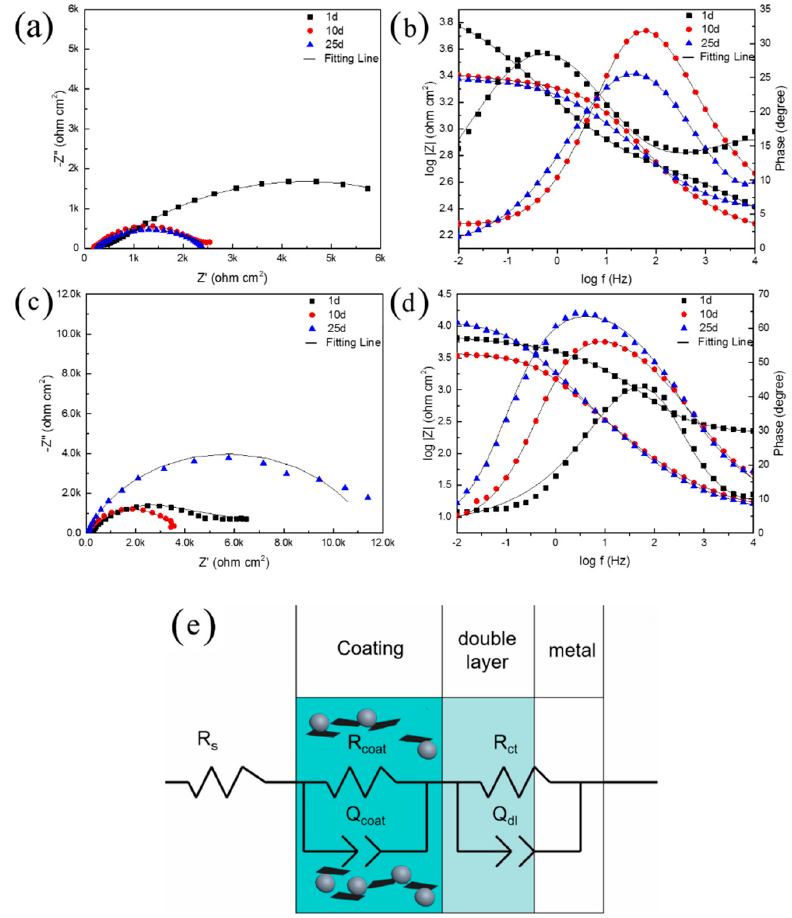
Figure 4. Nyquist and Bode diagrams measured on the coated sample ( a , b ) ZRPs ( c , d ) Gr0.6-ZRPs of immersion in a 3 wt. % NaCl solution with ( e ) equivalent circuit and model.